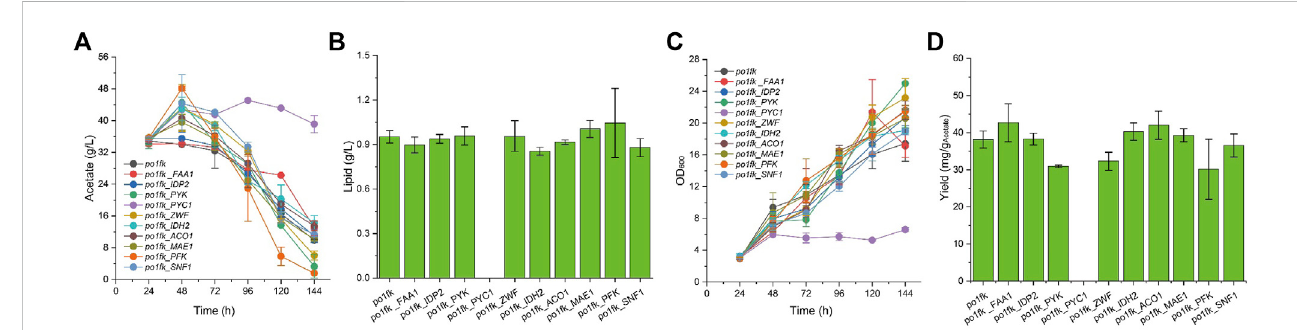
FIGURE 3 Time pro fi les of cell growth, acetate consumption, lipid titer and lipid yield in CSM-Acetate medium. (A) Glucose consumption of po1fk, po1fk_ylPYK, po1fk_ylACO1, po1fk_ylPFK, po1fk_ylSNF1, po1fk_ylIDP2, po1fk_ylZWF, po1fk_ylIDH2, po1fk_ylMAE, po1fk_ylPYC1, and po1fk_ylFAA; (B) Lipid titer of po1fk, po1fk_ylPYK, po1fk_ylACO1, po1fk_ylPFK, po1fk_ylSNF1, po1fk_ylIDP2, po1fk_ylZWF, po1fk_ylIDH2, po1fk_ylMAE, po1fk_ylPYC1, and po1fk_ylFAA; (C) Cell growth of po1fk, po1fk_ylPYK, po1fk_ylACO1, po1fk_ylPFK, po1fk_ylSNF1, po1fk_ylIDP2, po1fk_ylZWF, po1fk_ylIDH2, po1fk_ylMAE, po1fk_ylPYC1, and po1fk_ylFAA; (D) Lipid yield of po1fk, po1fk_ylPYK, po1fk_ylACO1, po1fk_ylPFK, po1fk_ylSNF1, po1fk_ylIDP2, po1fk_ylZWF, po1fk_ylIDH2, po1fk_ylMAE, po1fk_ylPYC1, and po1fk_ylFAA.